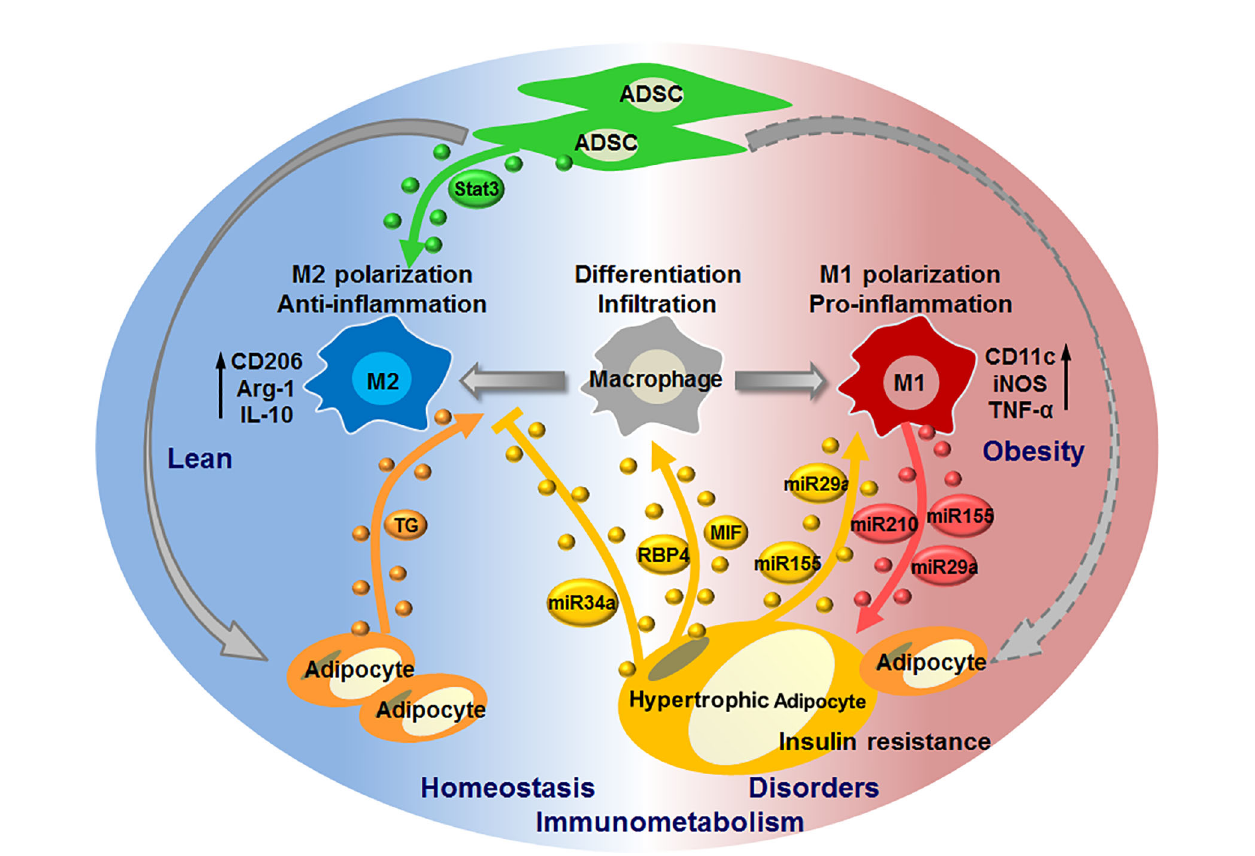
FIGURE 2 | EV-mediated interaction of macrophages with adipocytes or ADSCs in regulating immunometabolic homeostasis or disorders. Under healthy condition, ADSCs release EVs carrying active Stat3 to induce macrophage polarization toward M2 phenotypes; adipocytes release EVs to transfer lipid (triglyceride, TG) into macrophages, thereby maintaining immunometabolic homeostasis in WAT. In case of metabolic stress like obesity, hypertrophic adipocytes secret EVs with MIF, RBP4, miR-155, miR-34a, miR-29a to promote macrophage in fi ltration and M1 polarization, whilst suppress M2 polarization; M1 macrophages in turn cause insulin resistance of adipocytes through delivering miR-155, miR-29a, miR-210 via EVs, thus forming a vicious cycle to promote immunometabolic disorders in